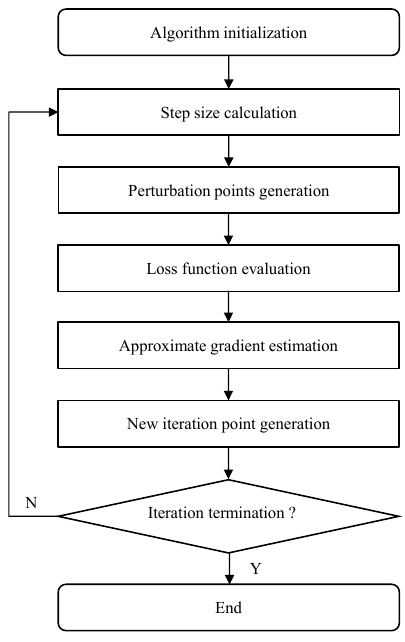
Figure 6. Flowchart of SPSA.